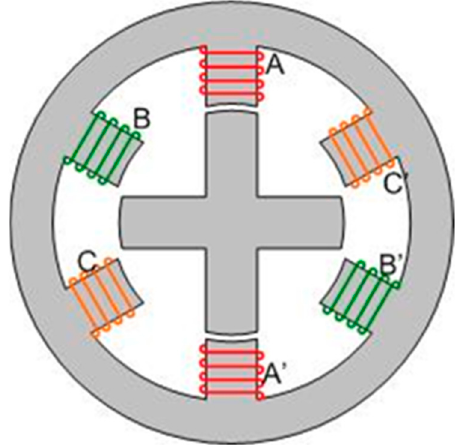
Figure 33. Structure of Switched Reluctance Machine (SRM).